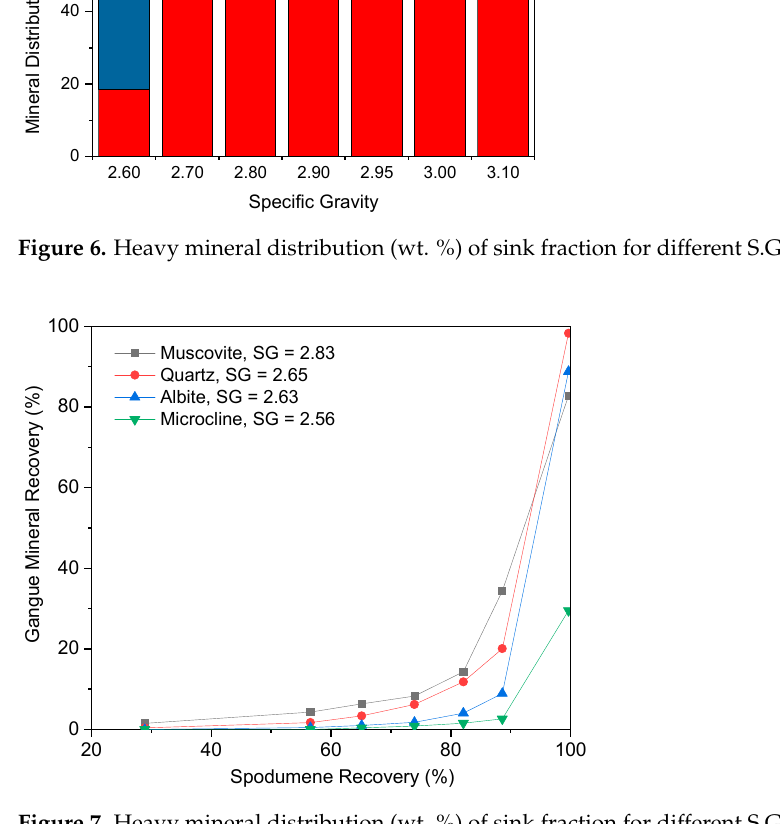
Figure 7. Heavy mineral distribution (wt. %) of sink fraction for different S.G. cut points.